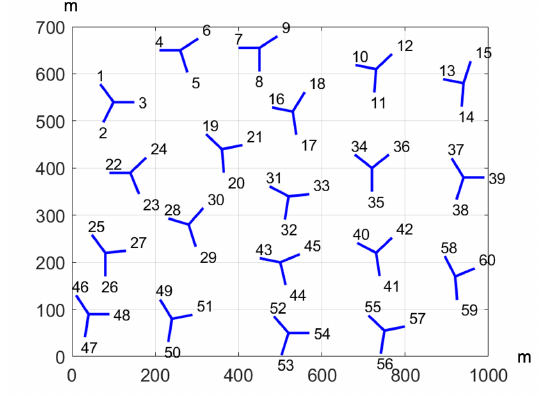
Figure 2. Dense urban scenario considered in this work.